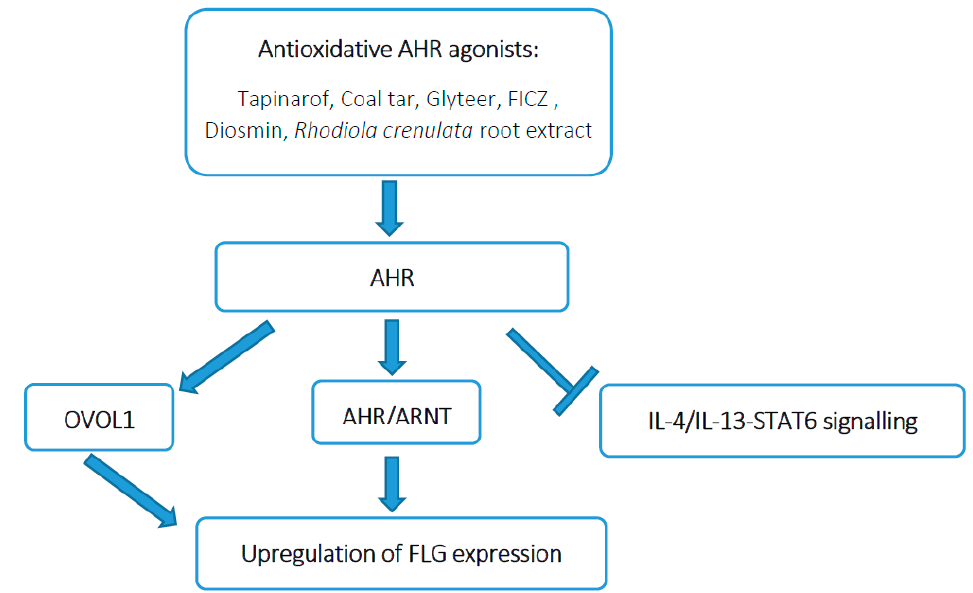
Figure 1. Simplified scheme of upregulation of filaggrin (FLG) by the aryl hydrocarbon receptor (AHR) axis. AHR activation upregulates FLG expression by direct activation of AHR/AHR-nuclear translocator (ARNT)/FLG gene promoter and upregulation of OVOL-like 1 (OVOL1) transcription factor signaling. Additionally, AHR activation inhibits the IL-4/IL-13-mediated signal transducer and activator of transcription (STAT)6 signaling and restores FLG expression. FICZ: The 6- Formylindolo[3,2-b]carbazole.